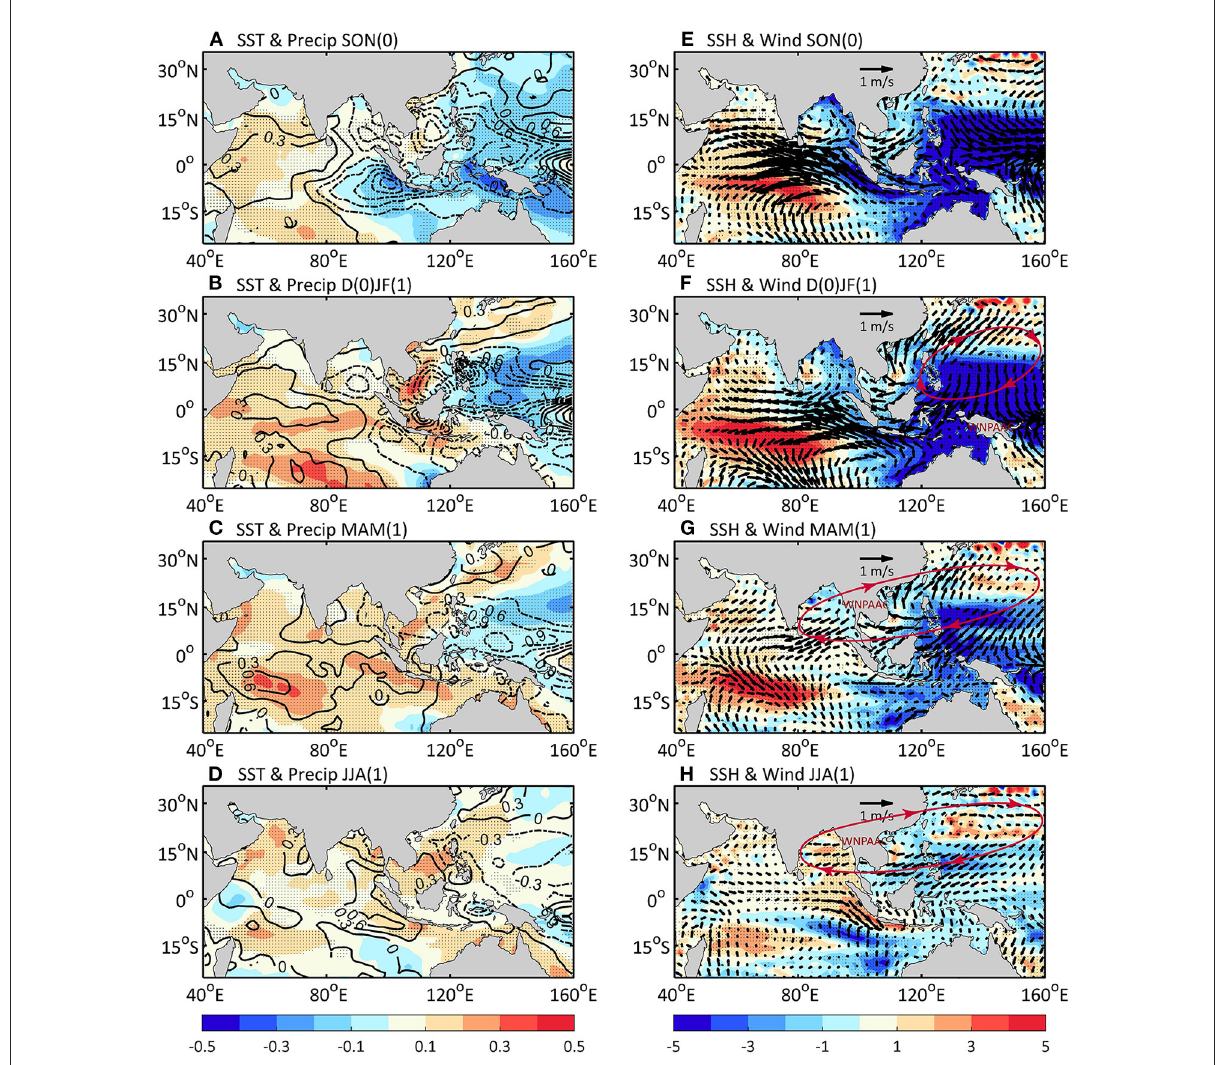
FIGURE5 Anomalies of monthly SST (shading, ◦ C) and precipitation (contour, mm day − 1 ) (A–D) , and monthly SSH (shading, cm) and wind (vector, m s − 1 ) (E–H) regressed onto NDJ Niño 3.4 SST. Red circle with arrows denotes WNP AAC in (F–H) . Stippling indicates confidence level > 95% for SSTa and SSHa based on students’ t- test. Based on OISST from 1982-2021, GPCP precipitation from 1982-2021, CMEMS SSH from 1993-2020, and CCMP wind from 1988-2021. Linear trends and seasonal cycles are